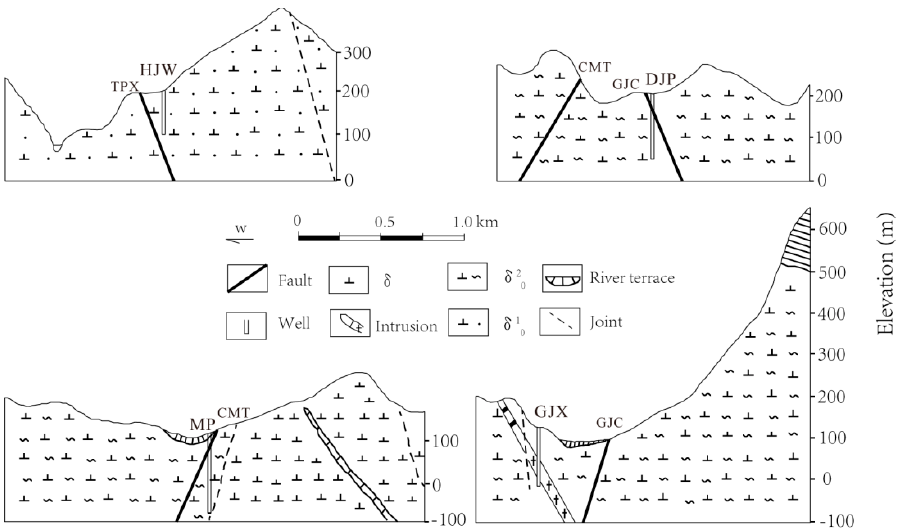
Figure 3. Relationship between the four wells and faults. The figure was adapted from Che [29].